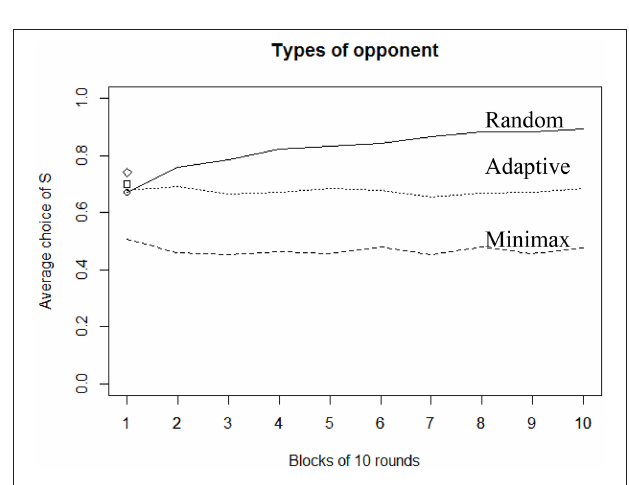
FIGURE 6 | Average proportion of choice (S) over time. Each block is 10 rounds.